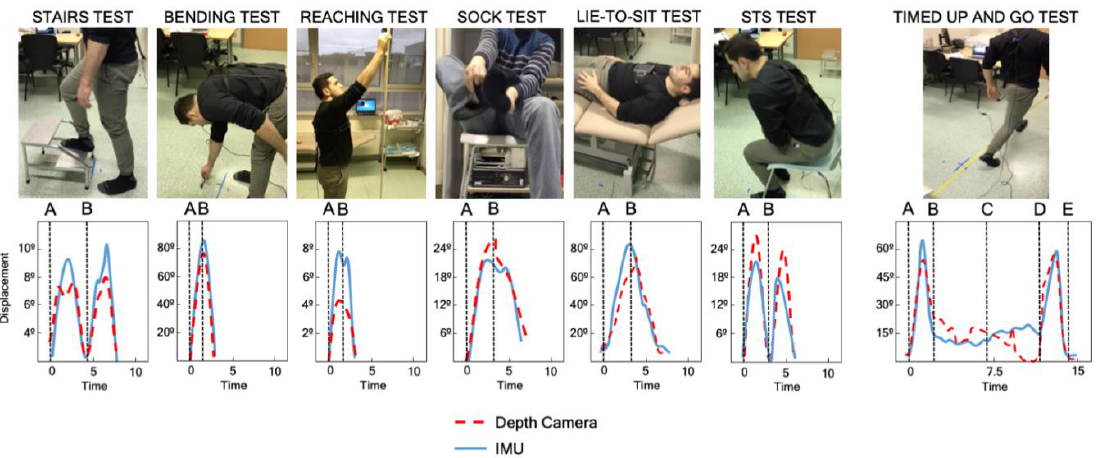
Figure 3. Functional tests and timed up-and-go test. Examples of kinematic pattern of each performance and control points.